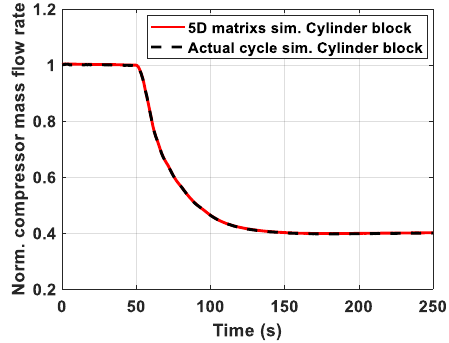
Figure 25. Compressor air flow rate time history.